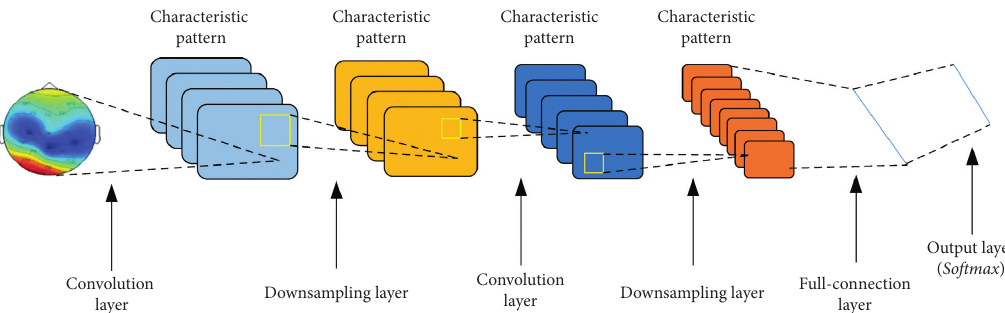
Figure 2: Complete CNN structure